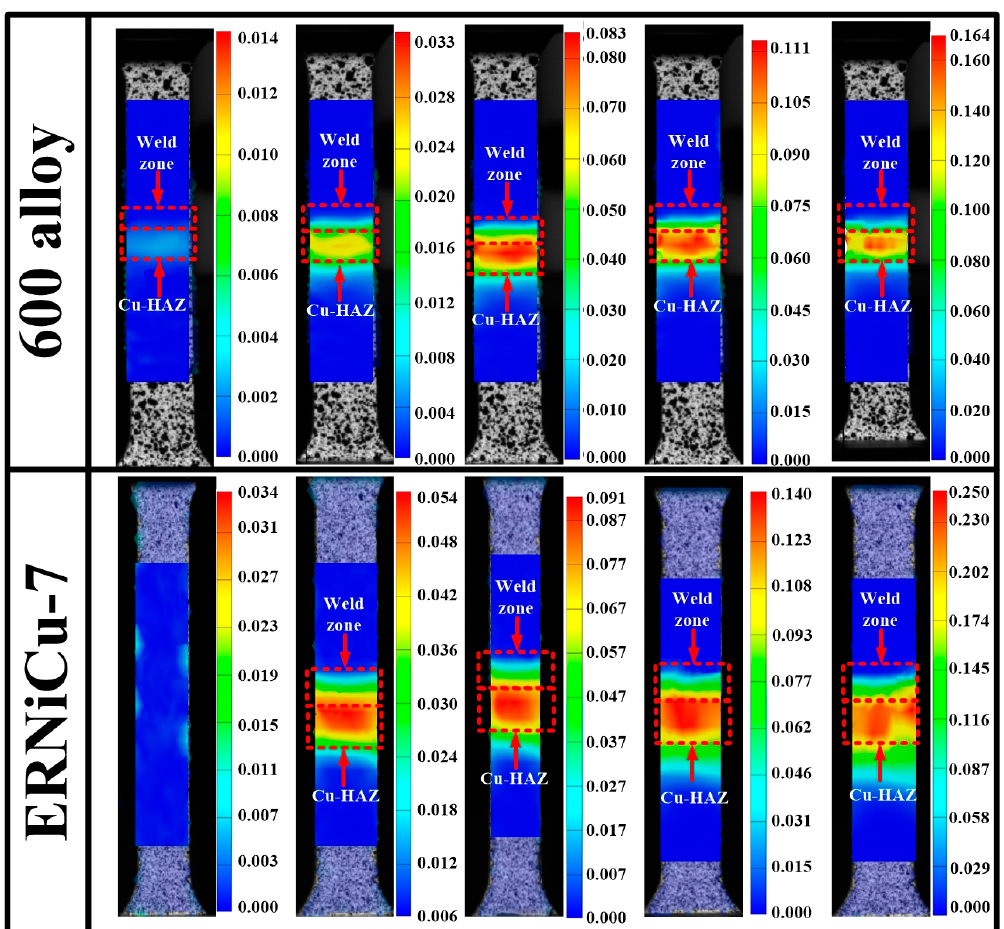
Figure 17. Sequential strain maps obtained through 2D-DIC .